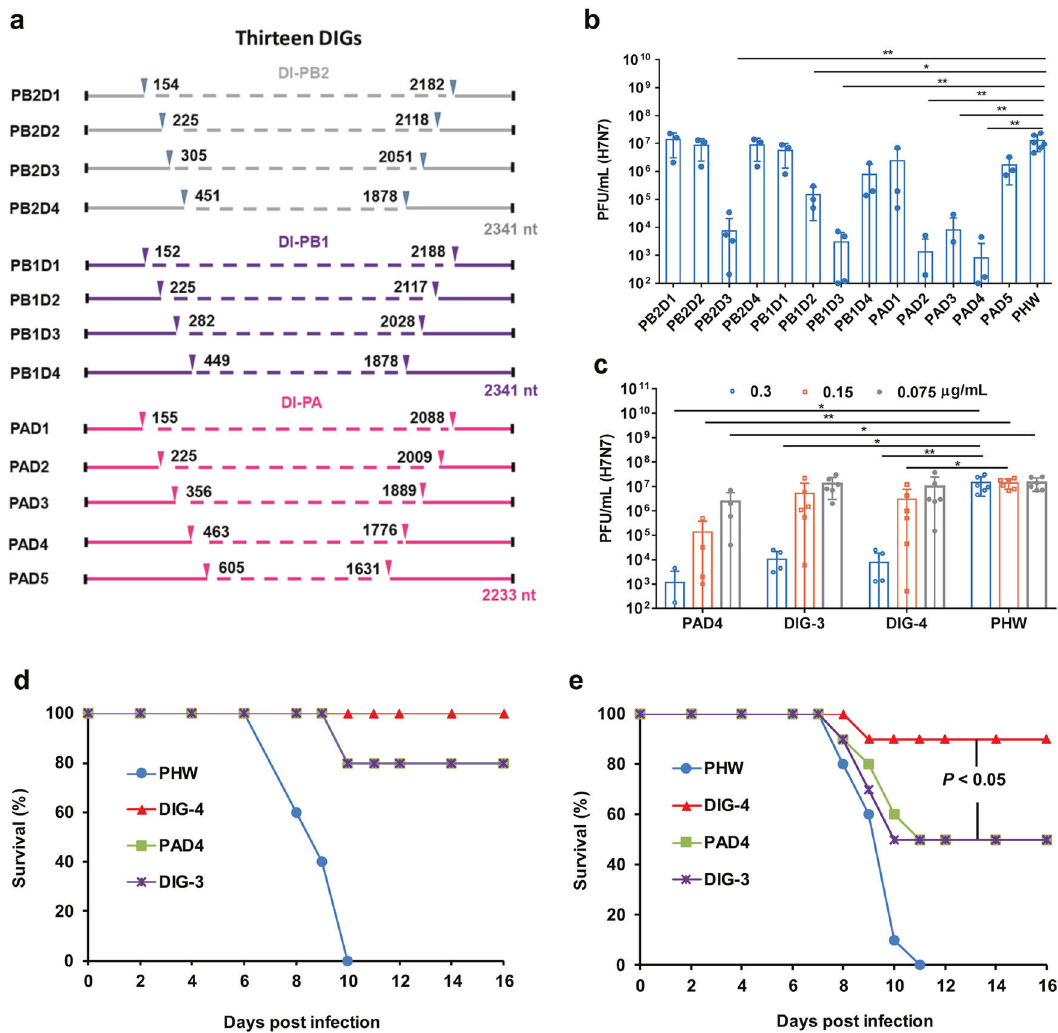
Fig. 2 The design of diverse lengths of in fl uenza DIGs and the antiviral ef fi ciency of DIGs. a Construction of defective interfering genes (DIGs). The diverse defective interfering (DI) genes of DI-PA, DI-PB1 and DI-PB2 with internal deletion were generated by fusion PCR. Dotted lines show the internal deletion in wild-type viral polymerase genes. The solid-line sequences of shortened viral polymerase gene PA, PB1 and PB2 were inserted into phw2000 vector, respectively. b The antiviral activity of single DIG against A(H7N7) virus in A549 cells. c The dose- dependent antiviral ef fi ciency of single PAD4 and combinational DIG-3 (including PAD3, PB2D3, and PB1D3) and DIG-4 (including PAD4, PB2D3, and PB1D3). The plasmid DIG or empty vector (PHW) with indicated concentrations were transfected into A549 cells and then cells were infected by H7N7 virus at 24 h post transfection. Viral titers in cell supernatants were measured by plaque assay at 48 h post infection. Data were presented as mean ± SD of at least three independent experiments. * indicates P < 0.05 and ** indicates P < 0.01. P values were calculated by the two-tailed Student ’ s t test. d The protection of two doses of DIG on A(H1N1)-infected mice. DIG-4 (5 µg/mouse, n = 5), PAD4 (5 µg/mouse, n = 5), DIG-3 (5 µg/mouse, n = 5), or empty vector (PHW, 5 µg/mouse, n = 5) packaged by TAT-P1 were intratracheally inoculated into mice at 48 h and 24 h before viral challenge. e The protection of one dose DIG on A(H1N1)-infected mice. DIG-4 (5 µg/mouse, n = 10), PAD4 (5 µg/mouse, n = 10), DIG-3 (5 µg/mouse, n = 10), or PHW (5 µg/mouse, n = 10) packaged by TAT-P1 were intratracheally inoculated into mice at 24 h before viral challenge. Survivals were generated from 10 mice in each group. P values were calculated by Gehan – Breslow – Wilcoxon (Supplementary Fig. 4a). When the weight ratios of peptide to plasmid DNA were more than 2, plasmid DNA could be completely packaged by these vectors. The in vitro transfection results indicated that TAT-P1 and TAT2-P1 showed similar transfection in 293 T cells (Supplementary Fig. 4b). Next, to assess the DNA transfection ef fi ciency of these vectors in vivo, pCMV-Luc